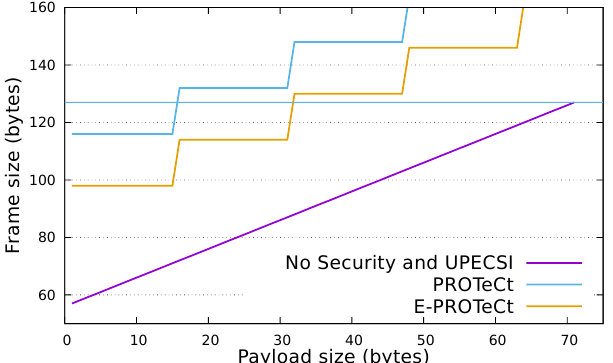
Figure 7. Overhead in the frame size for each